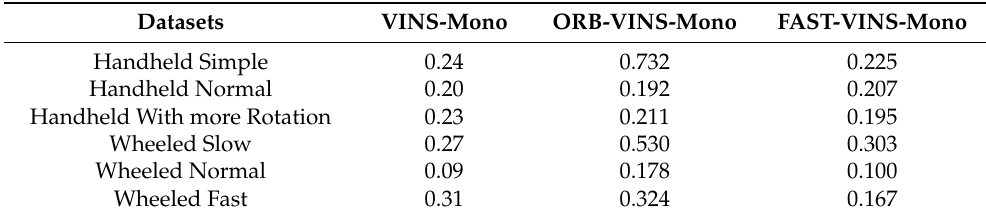
Table 1. RMSE comparisons between three different VIO methods in meters.